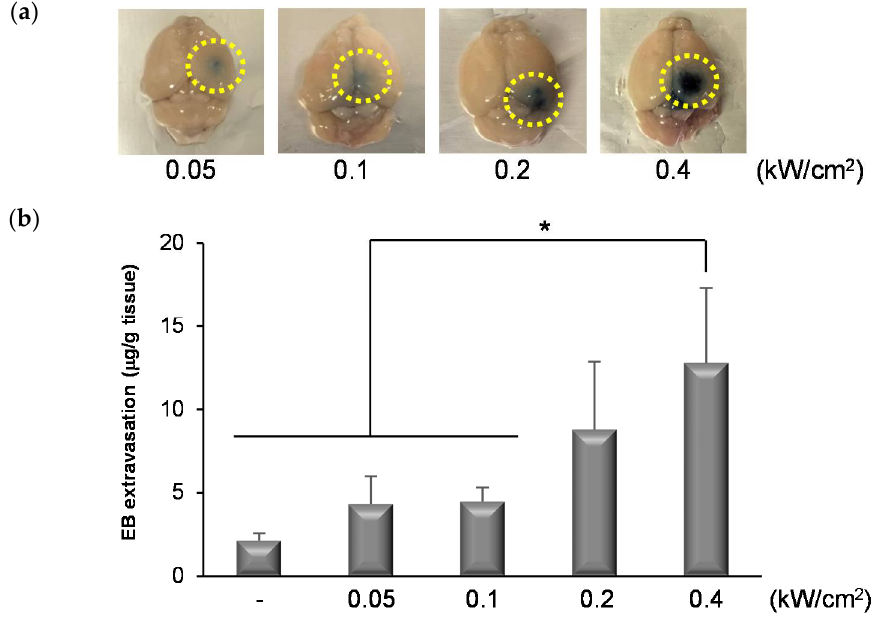
brain was collected. The bars show the mean and S.D. ( n = 3–6). * indicates p < 0.05 using a one-